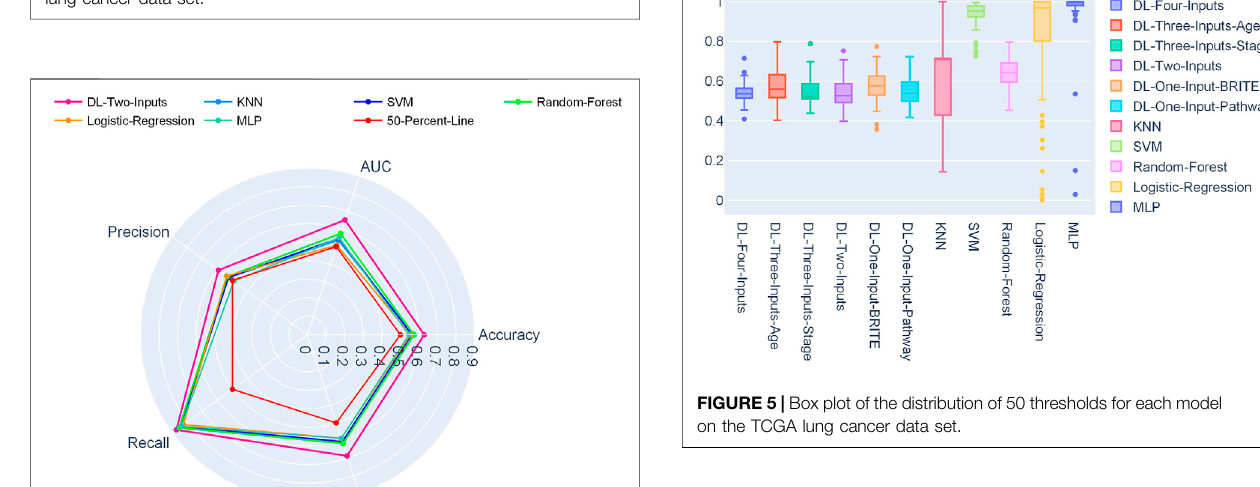
FIGURE 2 | Radar plot for comparison of the DL models on the TCGA lung cancer data set.